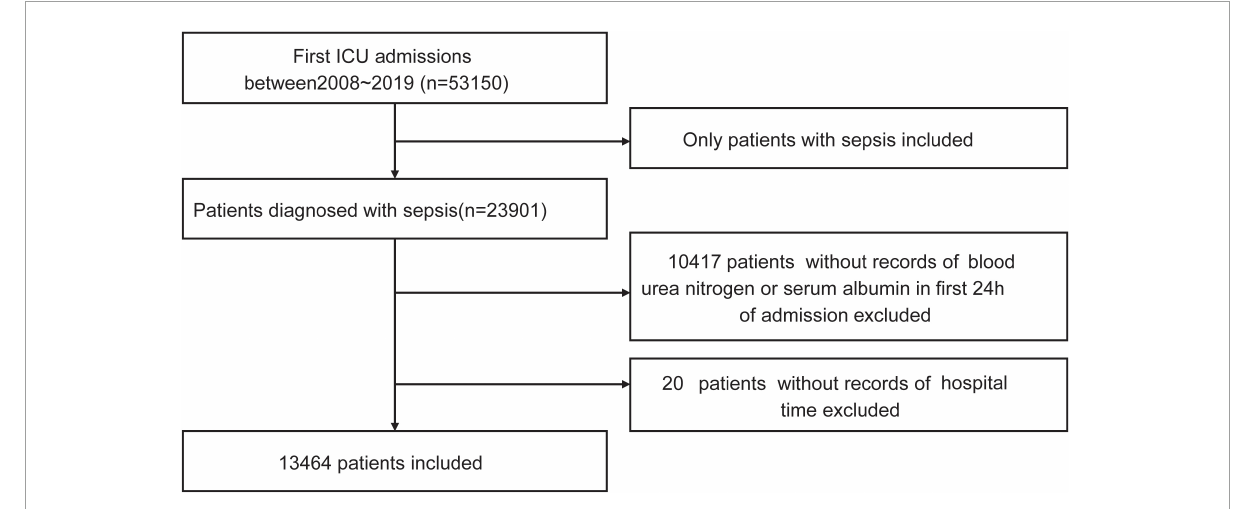
FIGURE1 Flowchart of study